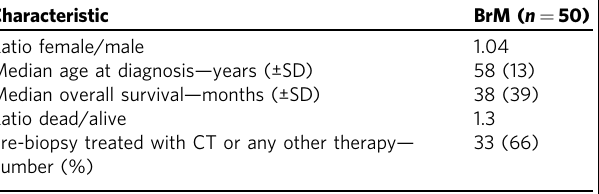
Table 1 Summary of the main clinical features of the cohort of